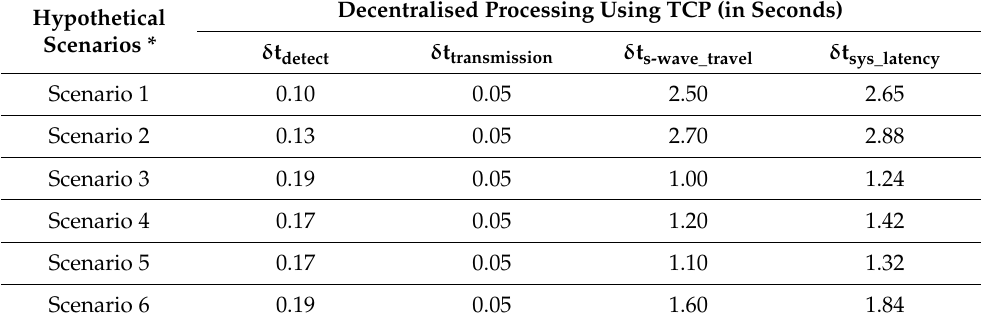
Table 1. Reported average latencies for the six hypothetical earthquake scenarios with the decen- tralised